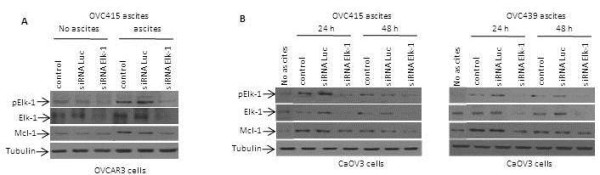
Elk-1 activation is essential for the control of Mcl-1 expression. (A) OVCAR3 cells were transfected with vehicule (control), control siRNA luciferase (siRNA Luc) or Elk-1 specific siRNA (siRNA Elk-1) and 24 h later cells were treated with OVC415 ascites for 1 h or left in medium with FBS. Lysates were obtained 1 h after the stimulation with ascites and immunoblots were probed with anti-phospho-Elk-1, anti-Elk-1 and anti-Mcl-1 antibodies. Tubulin was used as a loading control. (B) CaOV3 cells were transfected with vehicule, control siRNA Luc or Elk-1 specific siRNA and 24 or 48 h later cells were stimulated with either OVC415 (left panel) or OVC439 ascites (right panel). Lysates were obtained and immunoblotted with anti-Elk-1, anti-Mcl-1, anti-phospho-Elk-1 and anti-tubulin. Representative data from three independent experiments.